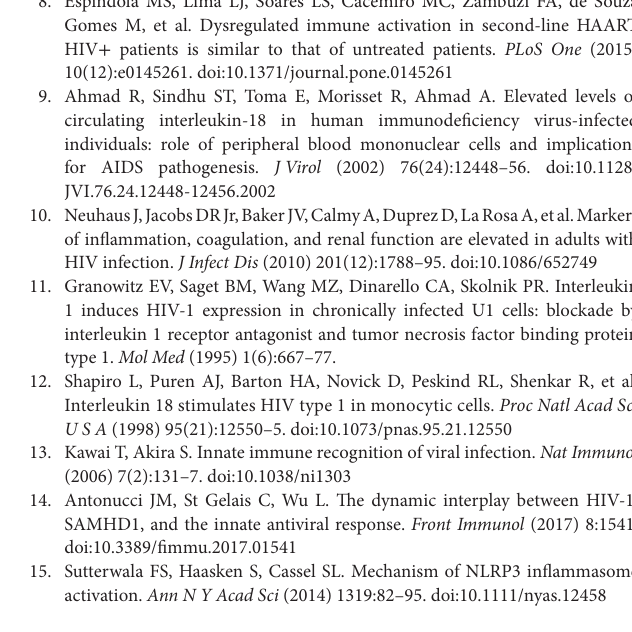
FigUre s1 | Viral load and CD4 + T-cells counts according to high-density lipoprotein (HDL) levels in human immunodeficiency virus type 1 (HIV-1) (HIV-1)-infected individuals. HIV-1-infected individuals were divided according to HDL levels (normal: > 40 mg/dL and low: < 40 mg/dL) and the viral load (a) and the CD4 + T-cells counts (b) were analyzed. The statistical comparison was made using the Mann–Whitney U tests with a 95% confidence level. Significant differences are represented in the upper part of this figure (* p < 0.05 and **p <